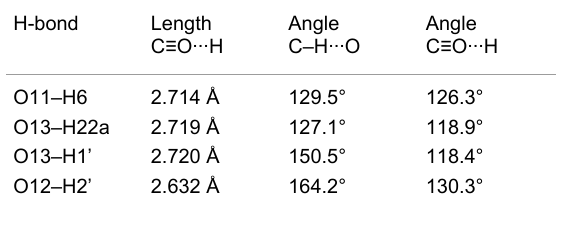
Table 7: Bond lengths and angles for the nonclassical H-bonds in 2k